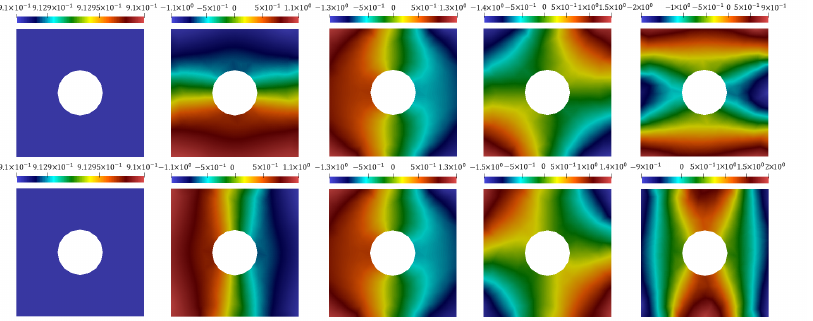
Figure 4. Illustration of the outer boundary multiscale basis functions for elasticity problem, ψ i k = 1, . . . ,5 (from left to right ). First row: displacement X-component. Second row: displacement